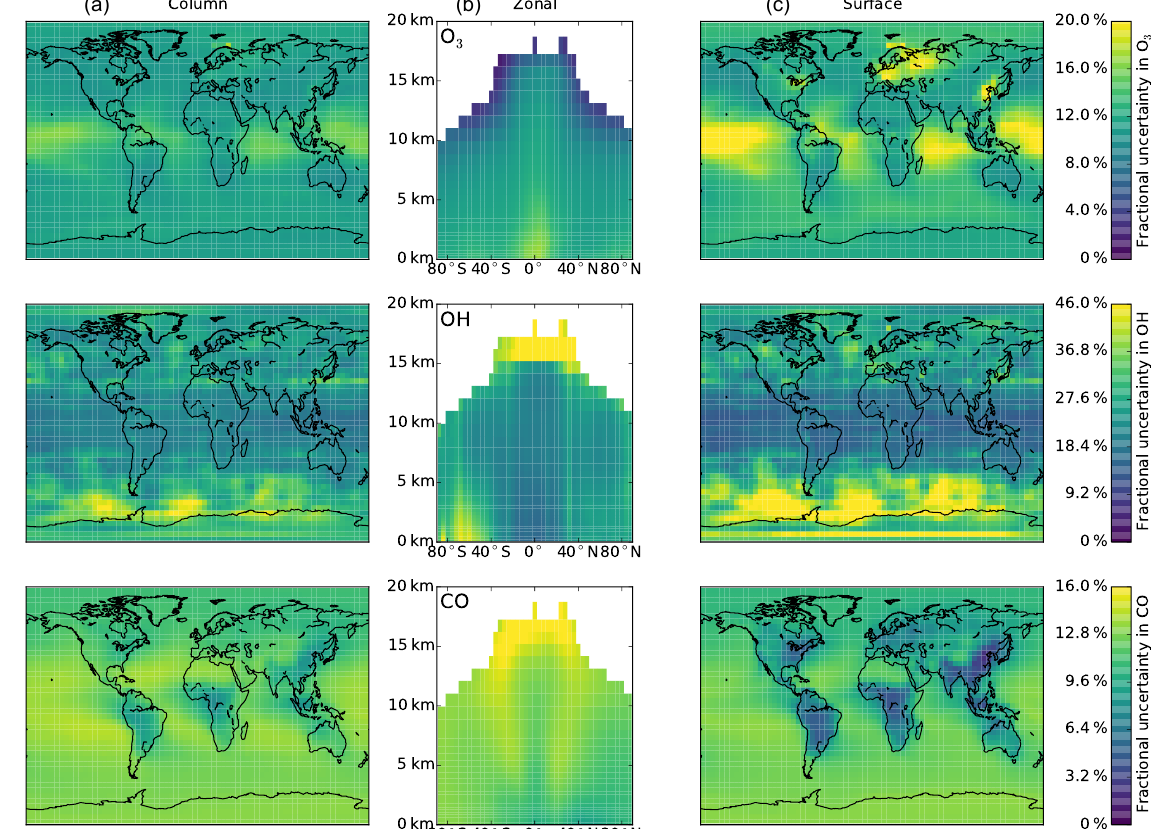
Figure 5. Spatial distribution of uncertainties: fractional uncertainties calculated for O 3 , OH and CO concentrations for the tropospheric column (a) , the zonal mean (b) and the surface (c) from adding together the individual reaction uncertainties from the 60 reactions studied in